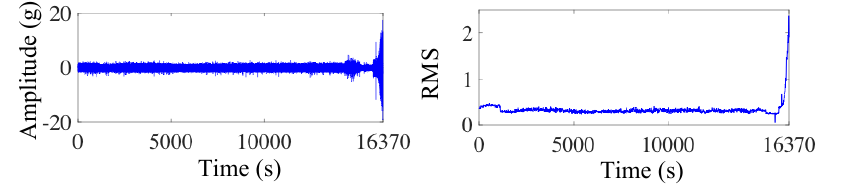
Figure 8. Vibration signals and RMS of bearing 3_1.